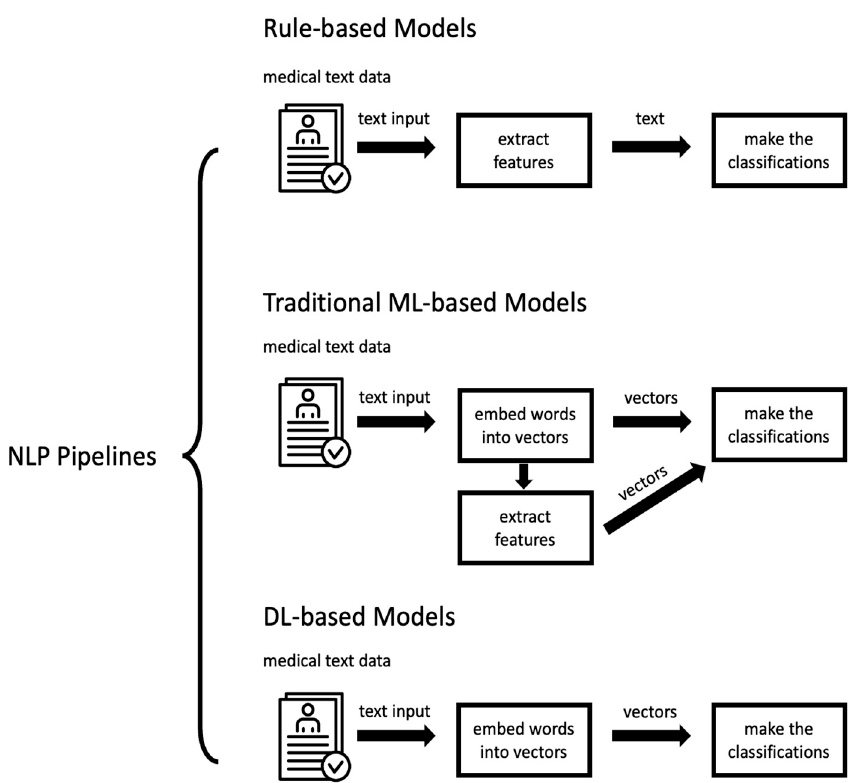
Figure 2. The overview pipeline of NLP applications for CAD in oncology: rule-based models, traditional ML-based models, and DL-based models.